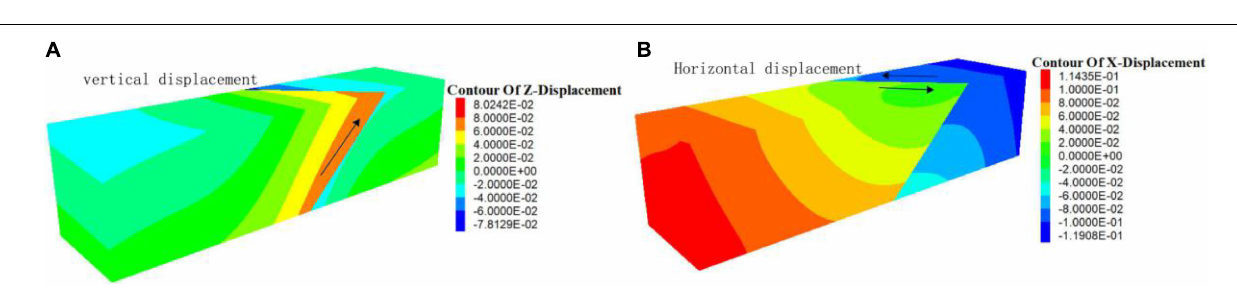
FIGURE 4 | Thrust left-handed slip diagram of scheme 3. (A) Shows the upward slip of the hanging wall of the fault in scheme 3, (B) shows that the hanging wall of scheme 3 fault slides to the